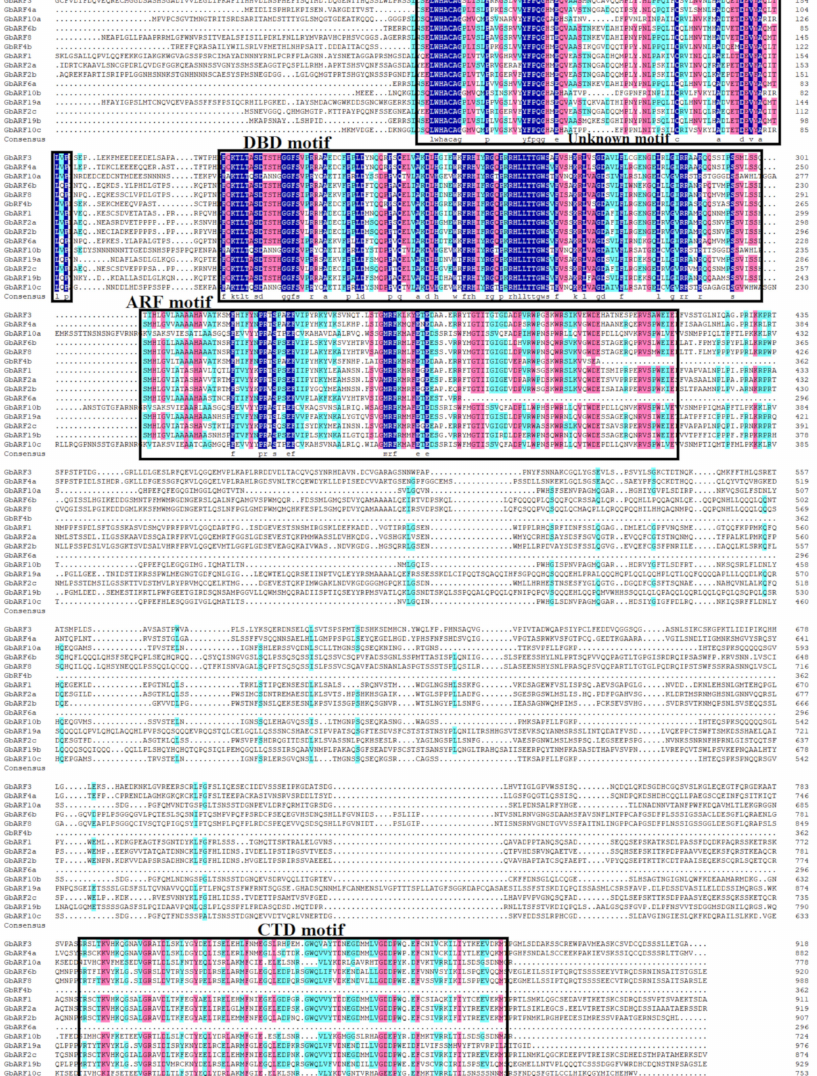
Figure 2. Multiple sequence alignment of GbARFs. Dark blue, light red, and light blue background indicates protein identity in 100%, 75%, and 50%, respectively. The DNA binding domain (DBD), auxin response factor (ARF) and C-terminal dimerization (CTD) domain regions were marked with black line